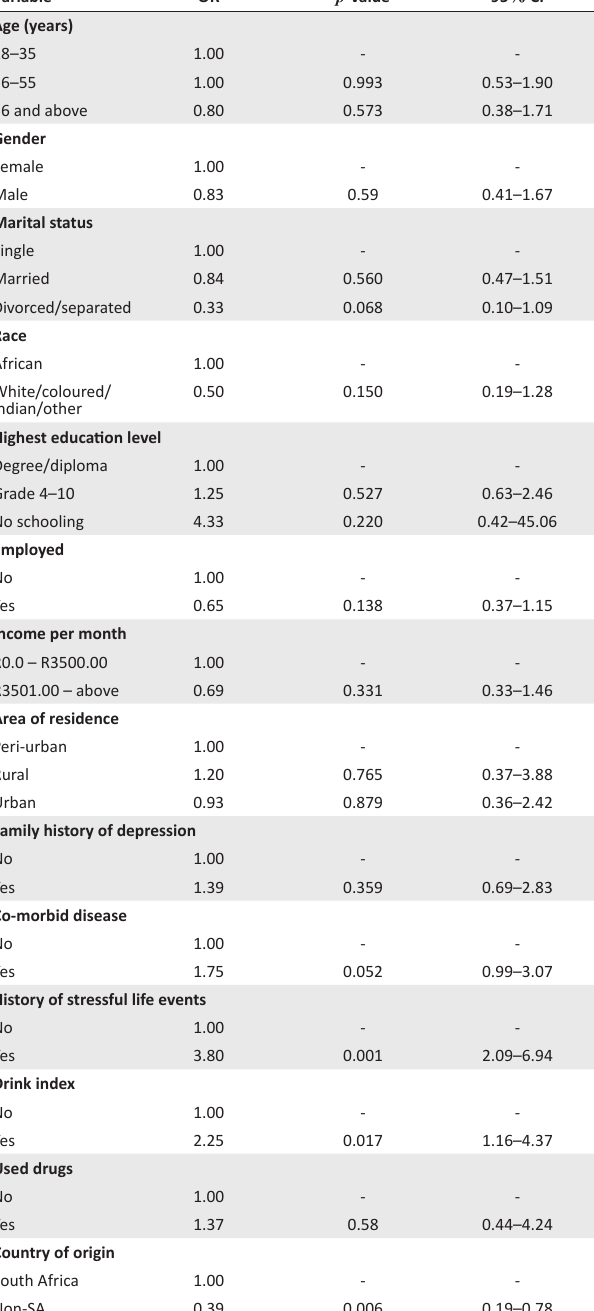
TABLE 3: Univariate logistic regression results for factors associated with screening positive on the patient health